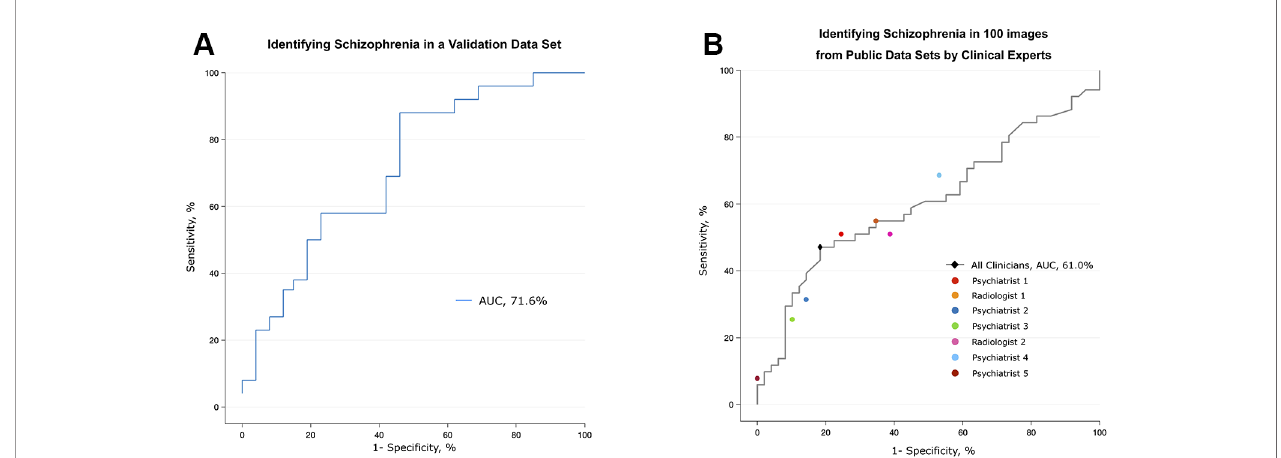
FIGURE 4 | Validation of the algorithm using a different data set and the performance of clinical specialists. (A) The algorithm trained with fi ve public data sets discriminated scans from patients with schizophrenia and normal subjects in the validation data set, which consisted of patients who were younger and at an earlier stage of the disease. (B) Classi fi cation performance of clinical specialists who had been semitrained regarding the structural characteristics of the brain in schizophrenia. The black diamond highlights the optimal operating point of all humans (sensitivity = 81.6%, speci fi city = 47.1%), and each colored circle shows the optimal operating point of each